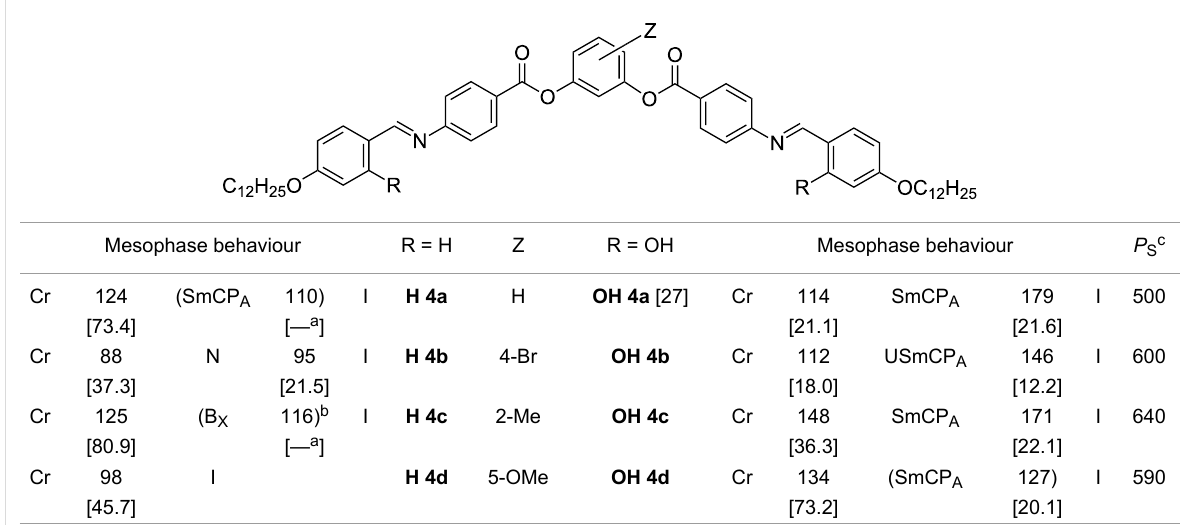
Mesophase behaviour